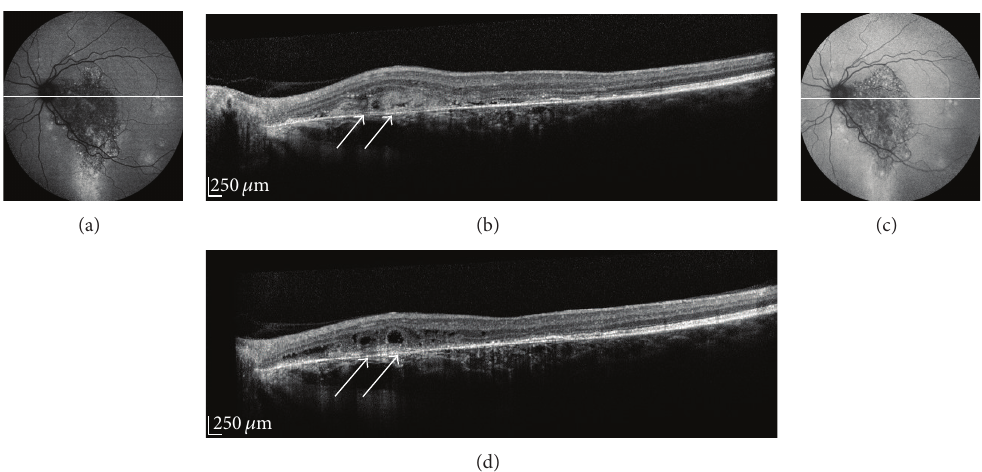
Figure 5: Fundus autofluorescence (FAF) images of a male with primary vitreoretinal lymphoma (PVRL). (a) FAF images of a patient with PVRL showing predominantly hyperautofluorescence in the form of granular hyper- and hypoautofluorescence, (b) OCT scan showing areas of nodular hyperreflective spots at the level of the RPE (arrows). (c) 2 years following the treatment the FAF image shows less marked granular hyperautofluorescence, as well as a fading of the nodular RPE hyperreflective spots previously noted on OCT ((d),